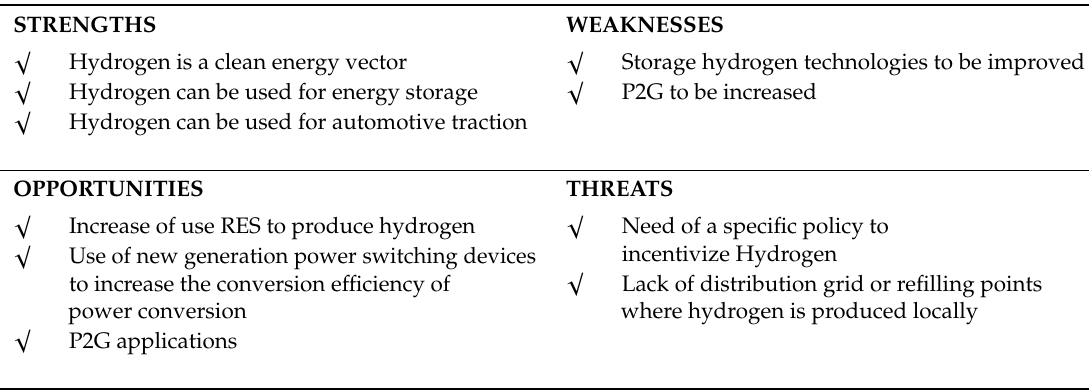
Table 1. SWOT analysis with strengths, weaknesses, opportunities, and threats within the framework of this review